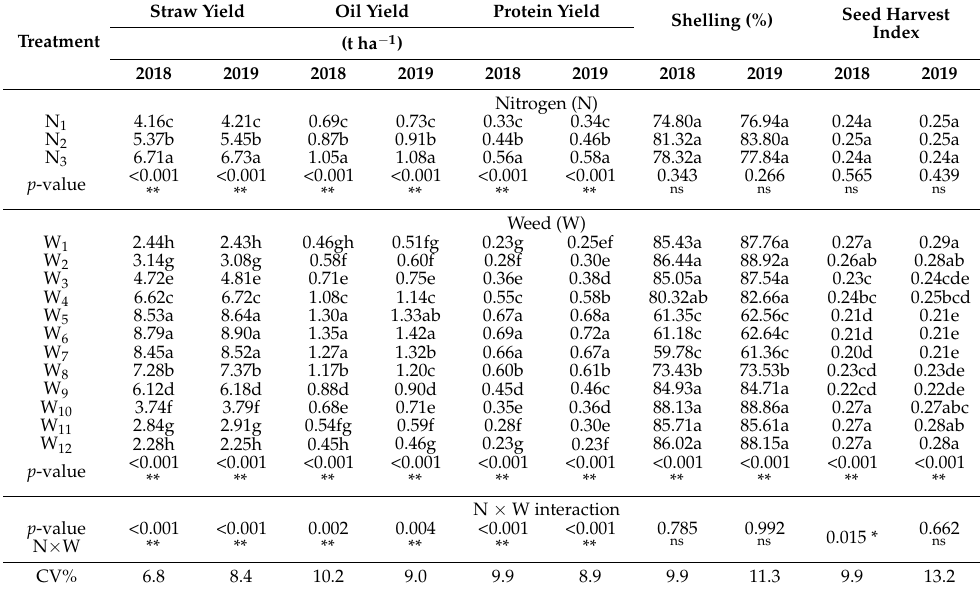
Table 8. Effect of nitrogen fertilization levels (N) and time (early and late) weed removal (W) on straw, oil and protein yield, shelling percentage and seed harvest index of peanut ( Arachis hypogaea L.) in 2018 and 2019